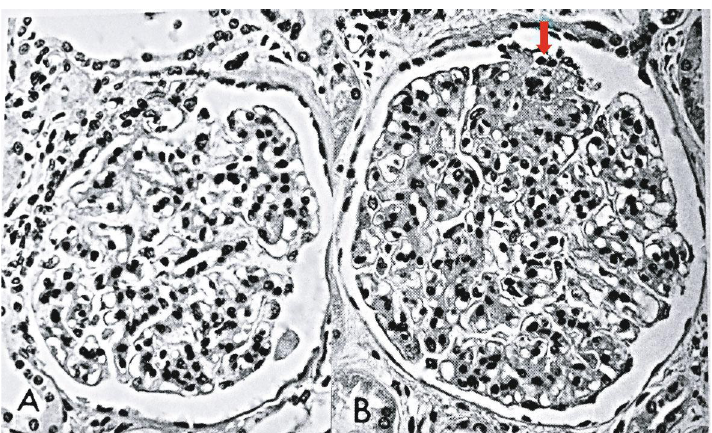
Figure 35: Glomeruli in segmental arterial mediolysis. The glomerulus in (a) exhibits an in tandem arrangement of hyperplastic mesangial cells in the glomerular stalks. Glomerulus in (b) in addition to mesangial hyperplasia also shows at the red arrow a segmental aggregation of matrix material obscuring the adjacent glomerular loop. Hematoxylin & eosin × 400 (adapted with permission from Laboratory Investigation 35(1) copyright 1976, Nature Publishing